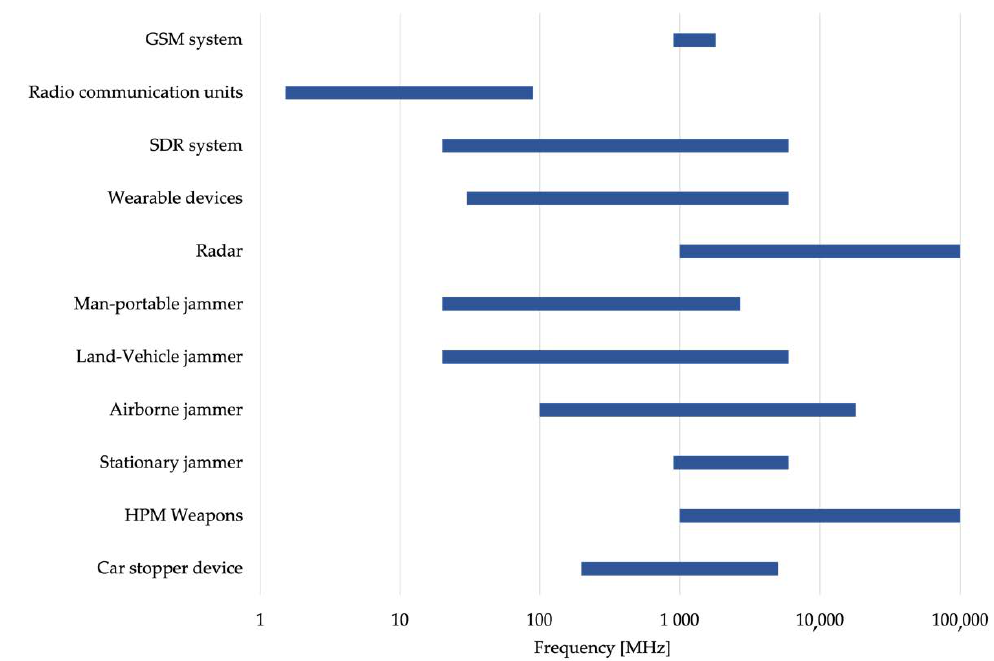
Figure 1. Distributions of the frequency ranges in the radiofrequency spectrum. Table 6. Devices with their